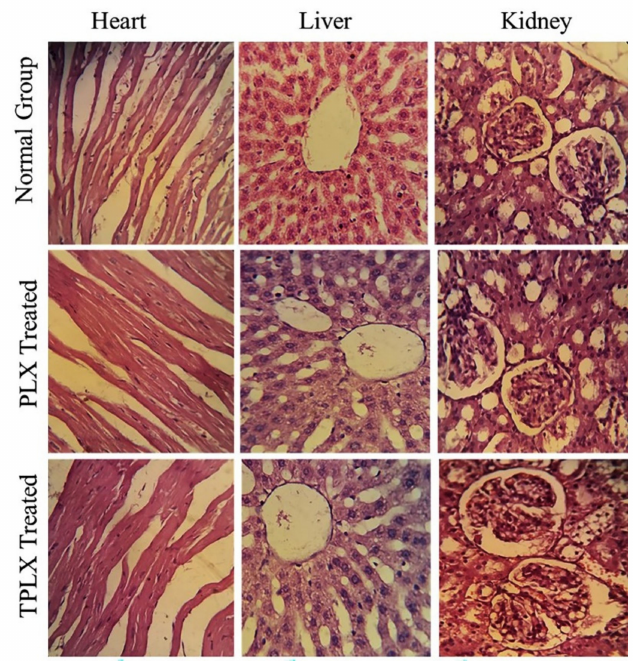
Figure 6. Histopathological evaluation of control group, PLX-treated group, and TPLX-treated group, illustrating the safety profile of modified and unmodified polymers. All the vital organs had normal physiological and anatomical